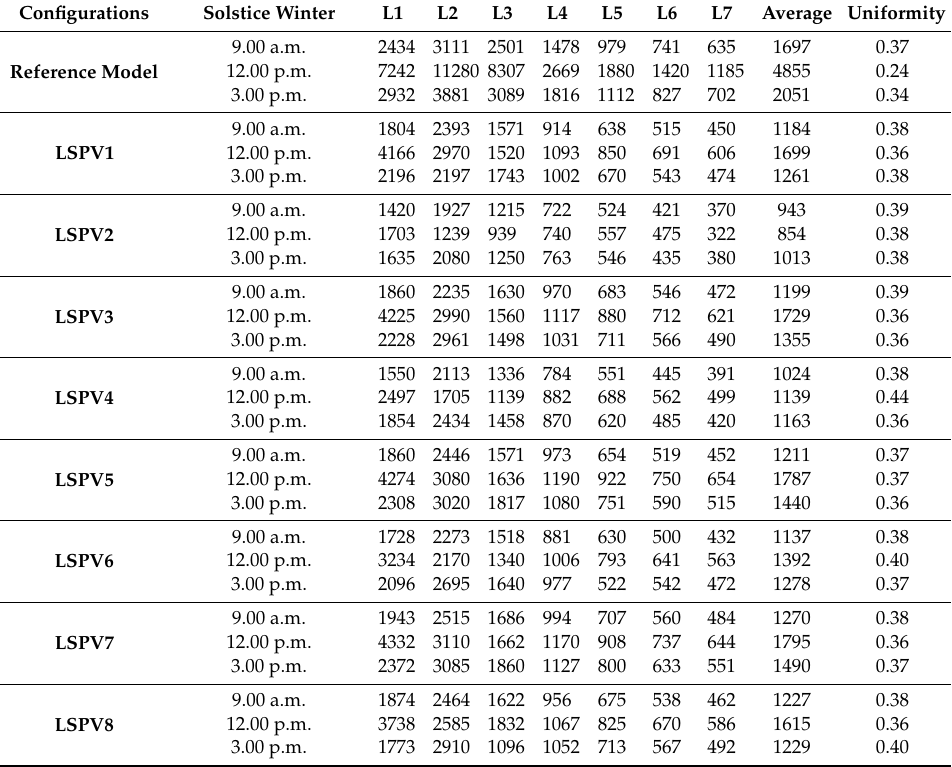
Table 8. The point in time illuminance of PV integration with light shelves and uniformity at solstice winter.